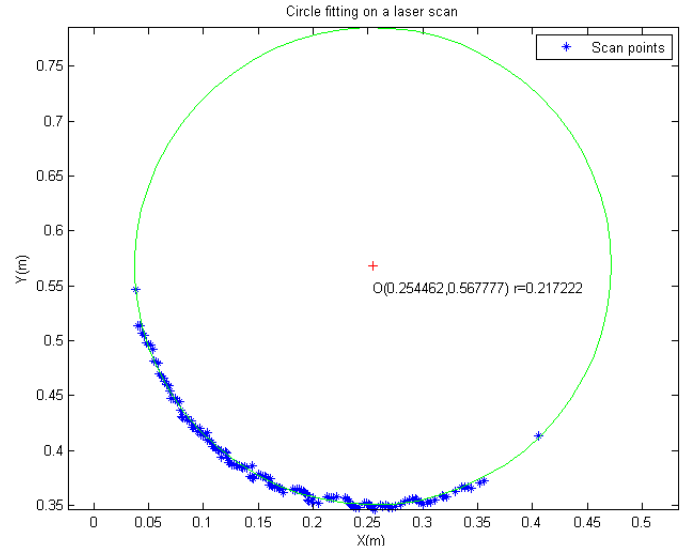
Figure 5. Circle fitting on a laser scan. The number of interior points (blue points) in the circle model (green circle) is 149.